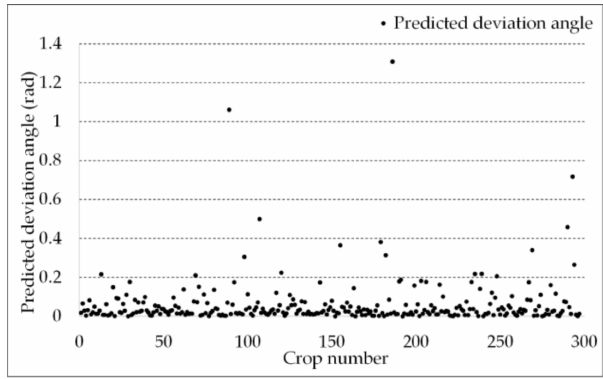
Figure 10. Scatter plot of growth direction prediction error.